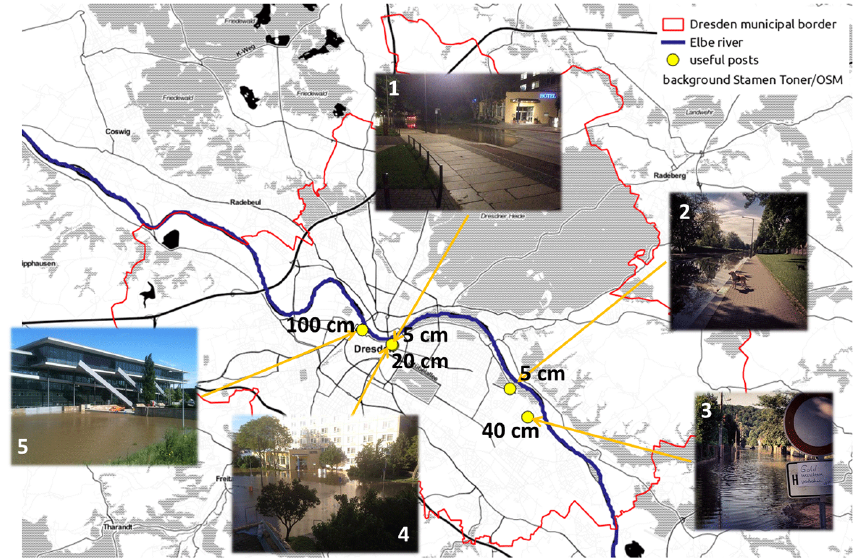
Figure 5. Location of useful photos retrieved with PostDistiller and inundation depths estimates. (Photos by Denny Tumlirsch (@Flitz- patrick), @ubahnverleih, Sven Wernicke (@SvenWernicke) and Leo Käßner